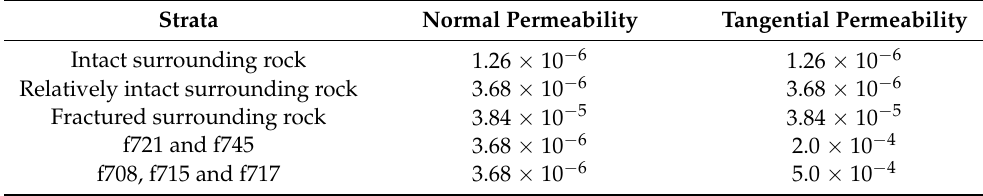
Table 4. Permeability of the strata and faults at the study area (unit: cm/s). Strata Normal Permeability Intact surrounding